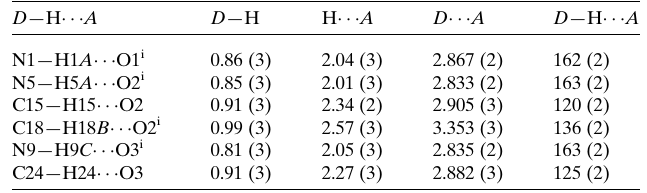
Table 2 Hydrogen-bond geometry (A˚ , (cid:3) ).